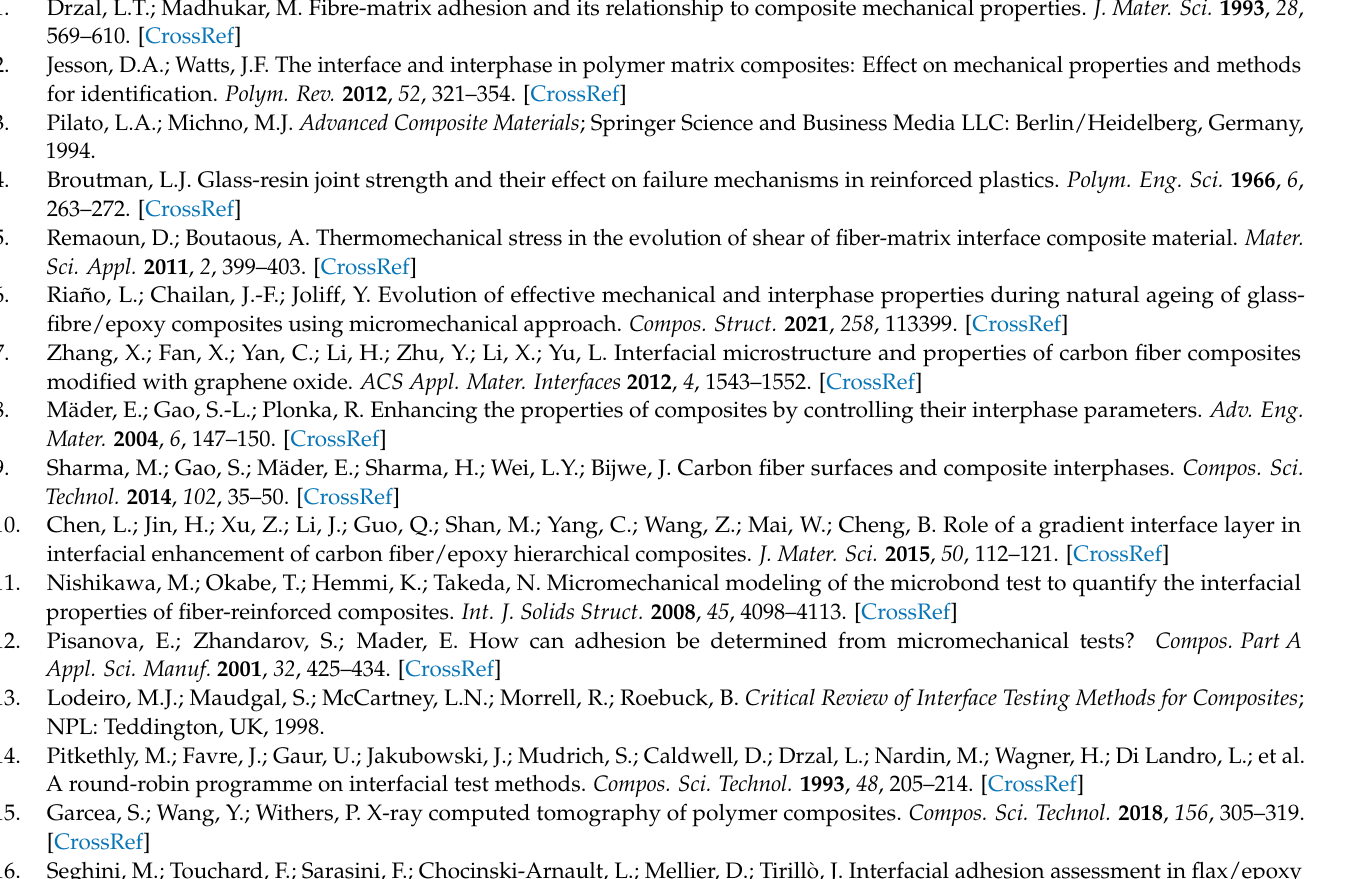
light microscopy: Figure S3: Post mortem polarized light microscopy image of the toughened and the non-toughened matrix system, indicating no visible difference in the degree of